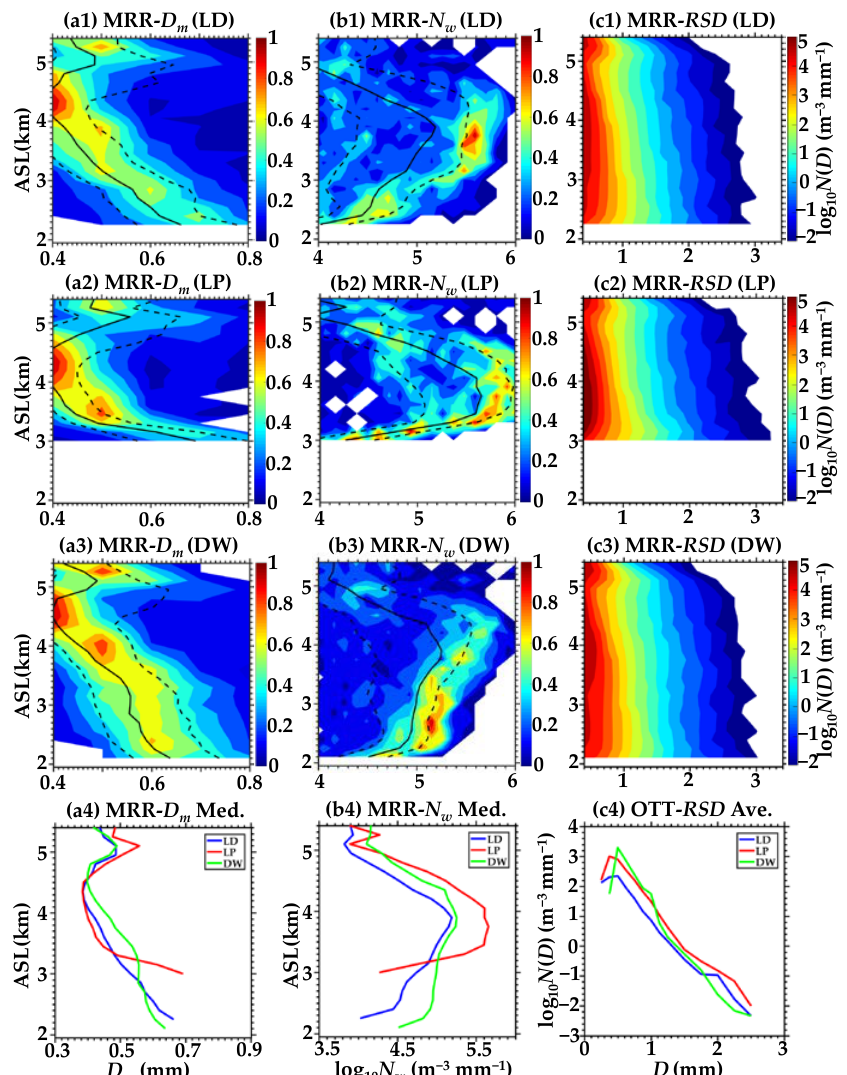
Figure 10. NCFADs of the mass-weighted mean diameter D m (mm) and the logarithm of the general- ized intercept parameter log 10 N w (m − 3 mm − 1 ) for the stratiform cloud and precipitation stage over ( a1 , b1 ) LD, ( a2 , b2 ) LP, and ( a3 , b3 ) DW. Contours represent occurrence. The black dashed lines rep- resent the 25th, 50th, and 75th percentiles. Subfigures ( a4 , b4 ) are median profiles of D m and log 10 N w over the three sites. Vertical distribution of raindrop size distribution RSDs for the stratiform cloud and precipitation stage over ( c1 ) LD, ( c2 ) LP, and ( c3 ) DW. Contours represent log 10 N(D) (m − 3 mm − 1 ). ( c4 ) is averaged RSDs on the ground at the LD, LP, and DW.